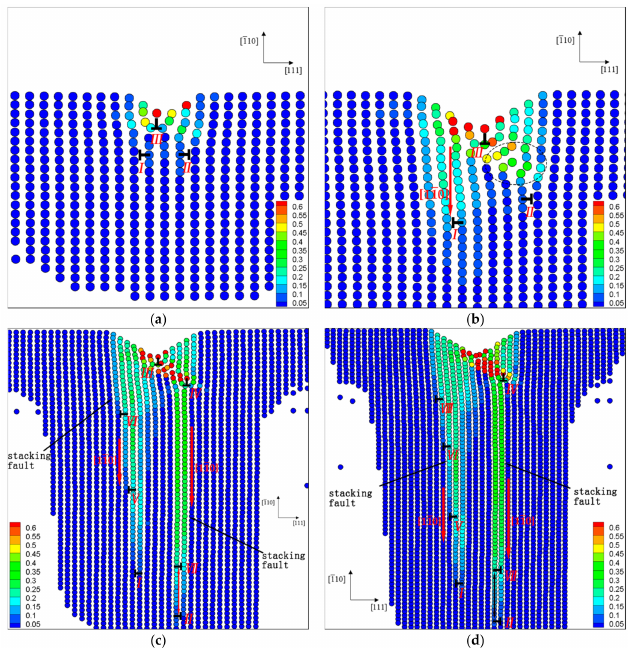
Figure 5. Strain distribution and dislocations beneath the wedged indenter with vertex angle of 60 ◦ during loading nanoindentation process: ( a ) h = 4.8 Å, ( b ) h = 7.8 Å, ( c ) h = 10.8 Å, ( d ) h = 12.0